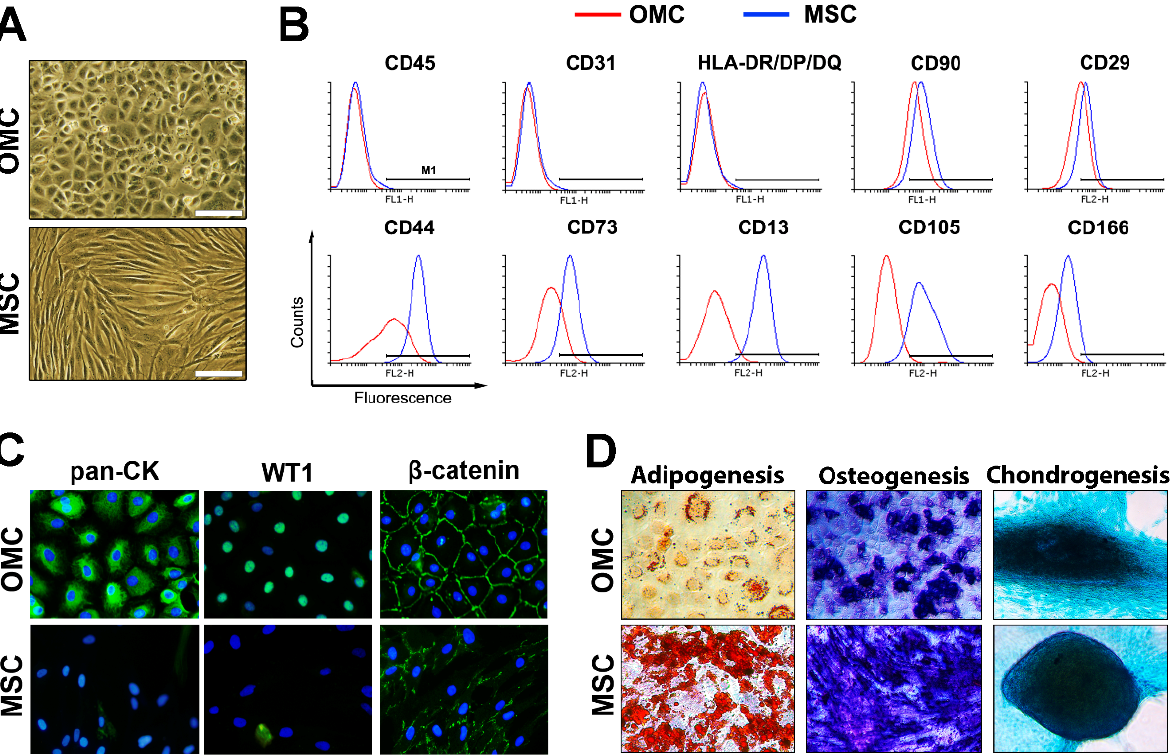
Figure 1. Phenotypic characterization of human omental mesothelial cells (OMC) and human mesenchymal stem cells (MSC). ( A ) Phase contrast pictures of confluent OMC and MSC cultures displaying typical cobblestone-type and fibroblastic morphologies, respectively. Scale bar is 100 µ m. ( B ) Flow cytometric analysis of OMC and MSC for expression of hematopoietic (CD45), endothelial (CD31), HLA class II (HLA-DR/DP/DQ), and stromal/mesenchymal (CD90, CD29, CD44, CD73, CD73, CD13, CD105, and CD166) cell markers. Histograms for OMC and MSC are red and blue, respectively. M1 bar marks positivity delimited from isotype histograms (not shown). ( C ) Im- munofluorescence analysis of OMC and MSC showing highly expressed epithelial (pan-cytokeratin or pan-CK) and mesothelial (Wilm’s tumor protein 1 or WT1) cell markers in OMC, but not in MSC, while the cell–cell junction protein β -catenin was expressed in both cell types. ( D ) Multilineage differentiation assay of OMC and MSC revealed limited adipogenic differentiation of OMC (Oilred O staining) compared to MSC. In contrast, OMC displayed more similar osteogenic and chondrogenic differentiation compared to MSC. ( A – C ) OMC used are ALIC1